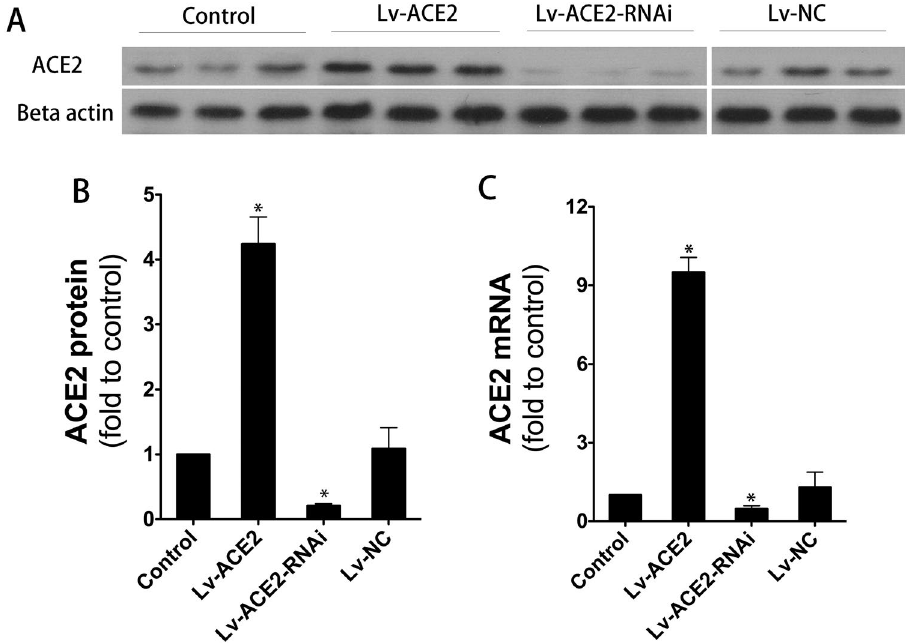
Figure 1. Efficiency of gene transfer at two weeks after Lenti-Ace2 and Lenti-Ace2-RNAi delivery. ( A , B ) Western-blotting analysis showed that ACE2 expression of rat lung tissue was significantly increased in the Lv-ACE2 group and decreased in the Lv-ACE2-RNAi group, as compared with the control group. ( C ) Quantitative analysis of ACE2 mRNA levels by using RT-PCR. Lung ACE2 mRNA levels were significantly increased by Lenti-ACE2 transfection, which were suppressed by Lenti-ACE2-RNAi transduction. The Data are represented as mean ± SD. * p < 0.05, versus control group (n = 3, per group). Please note that for A , lanes 1–9 and lanes 10–12 are from two gels run in parallel. A single loading control was used, for the gel carrying lanes